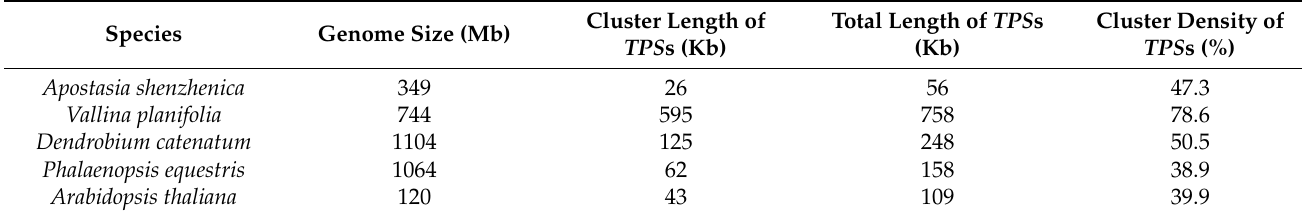
Arabidopsis thaliana